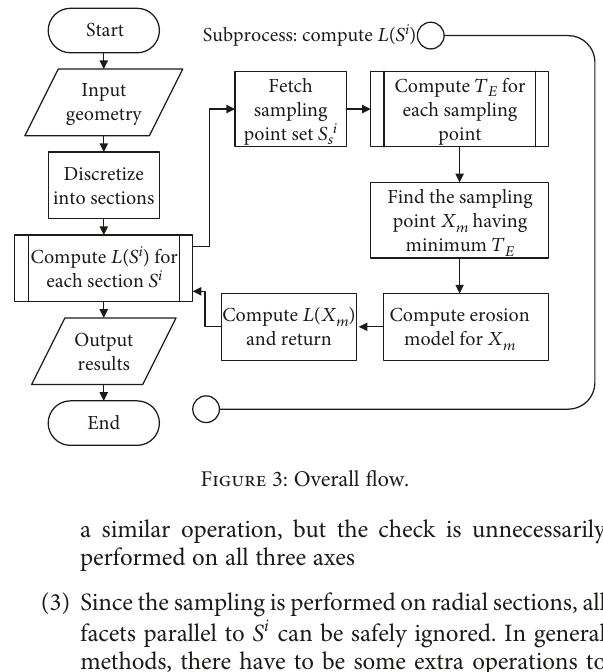
Figure 3: Overall fl ow.